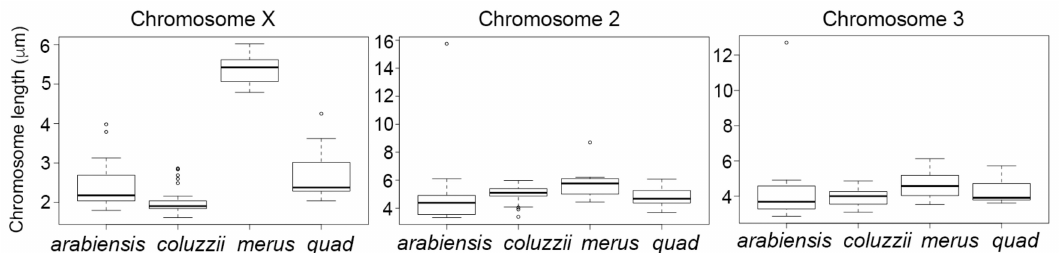
Figure 7. Lengths of the metaphase chromosomes in species from the An. gambiae